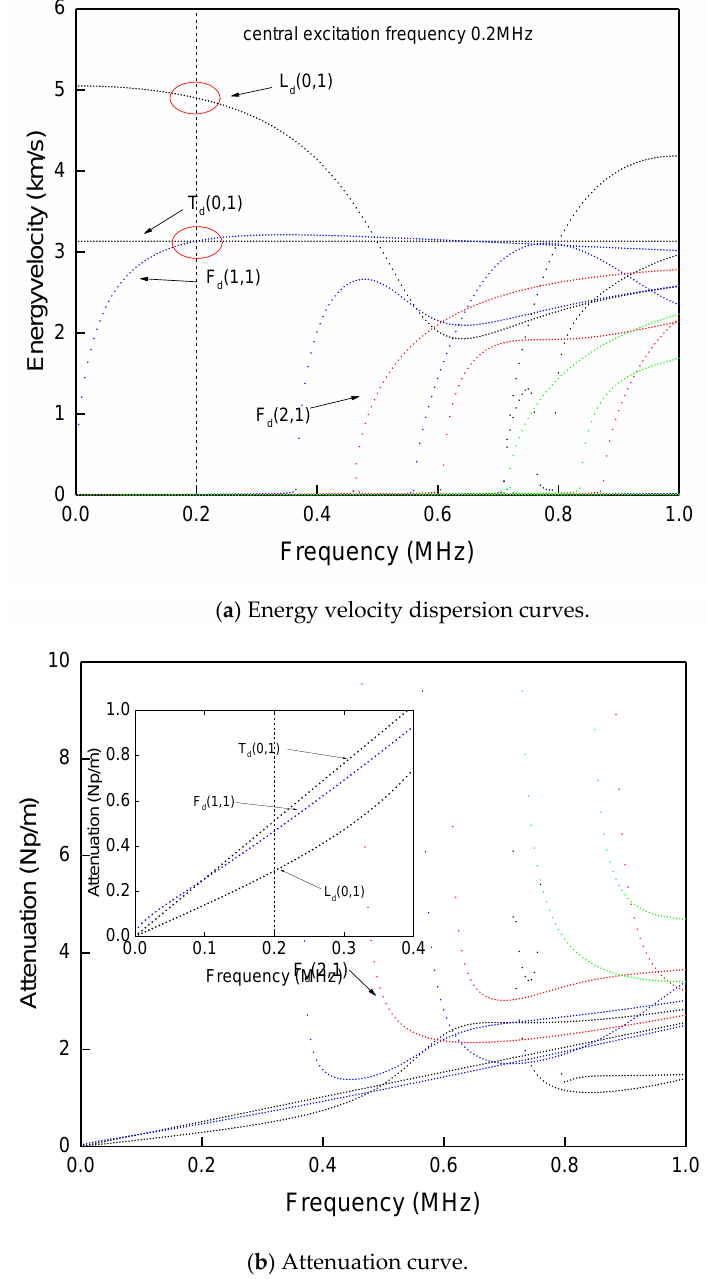
Figure 15. SAFE calculation results on a viscoelastic steel wire for narrowband tone burst excitation: ( a ) Energy velocity dispersion curves; ( b ) Attenuation curve.